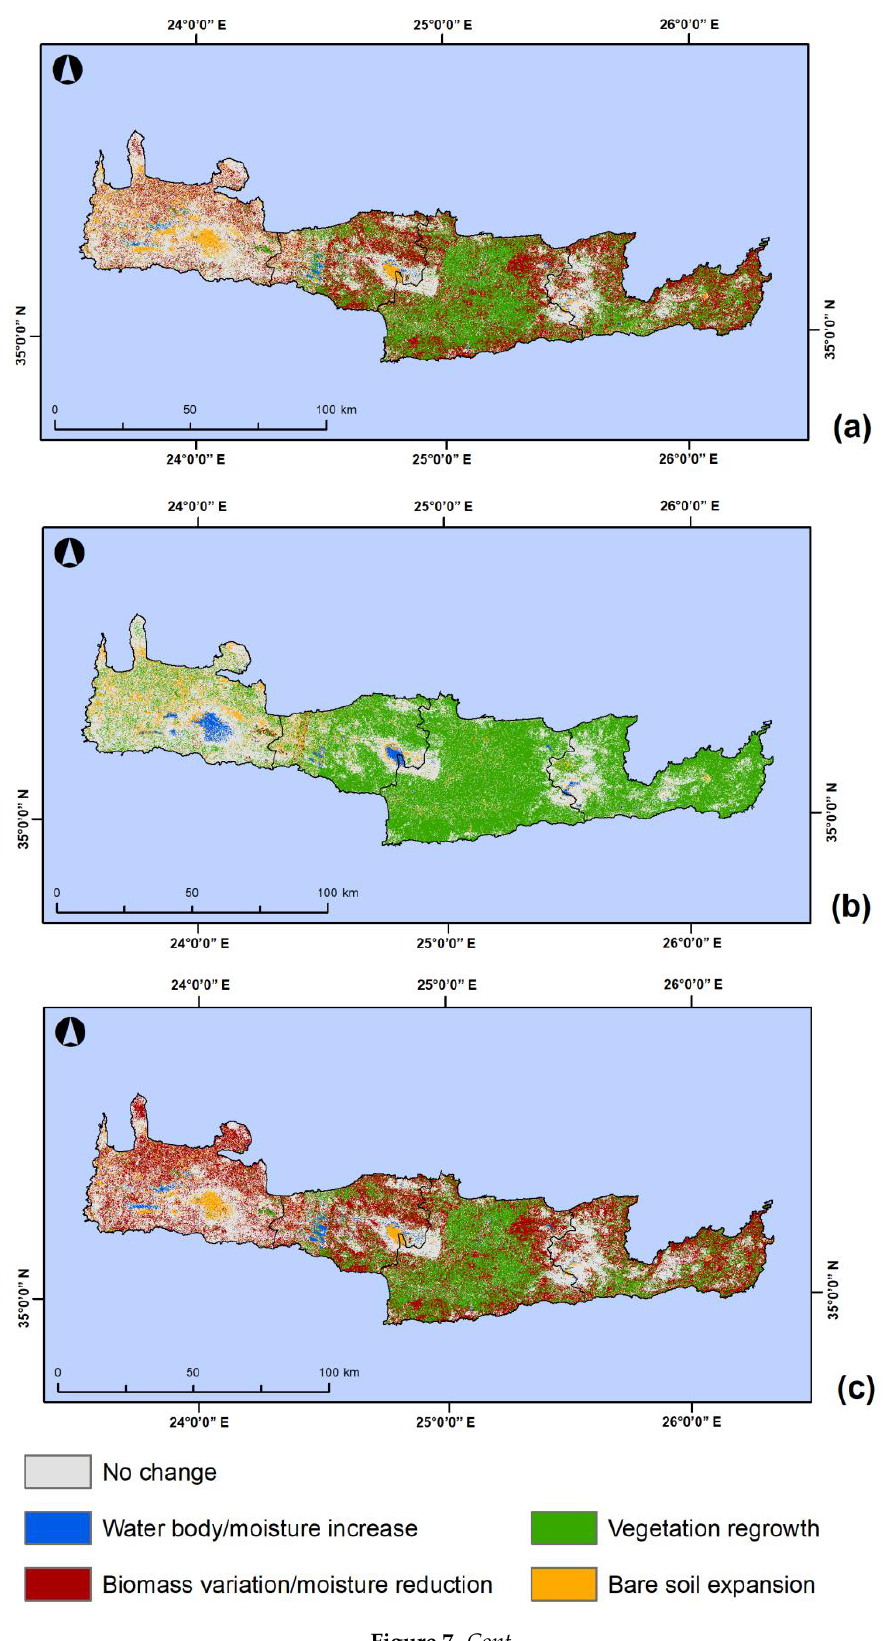
Figure 7. Cont Figure 7. Cont.